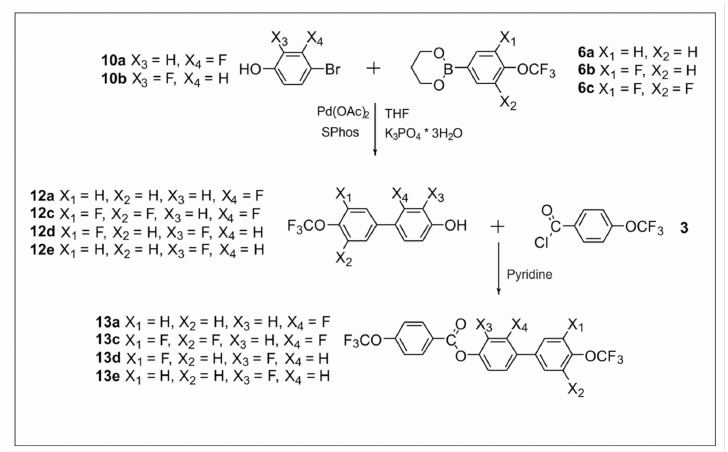
Figure 5. Synthesis of ester derivatives 13a , 13c , 13d , and 13e .